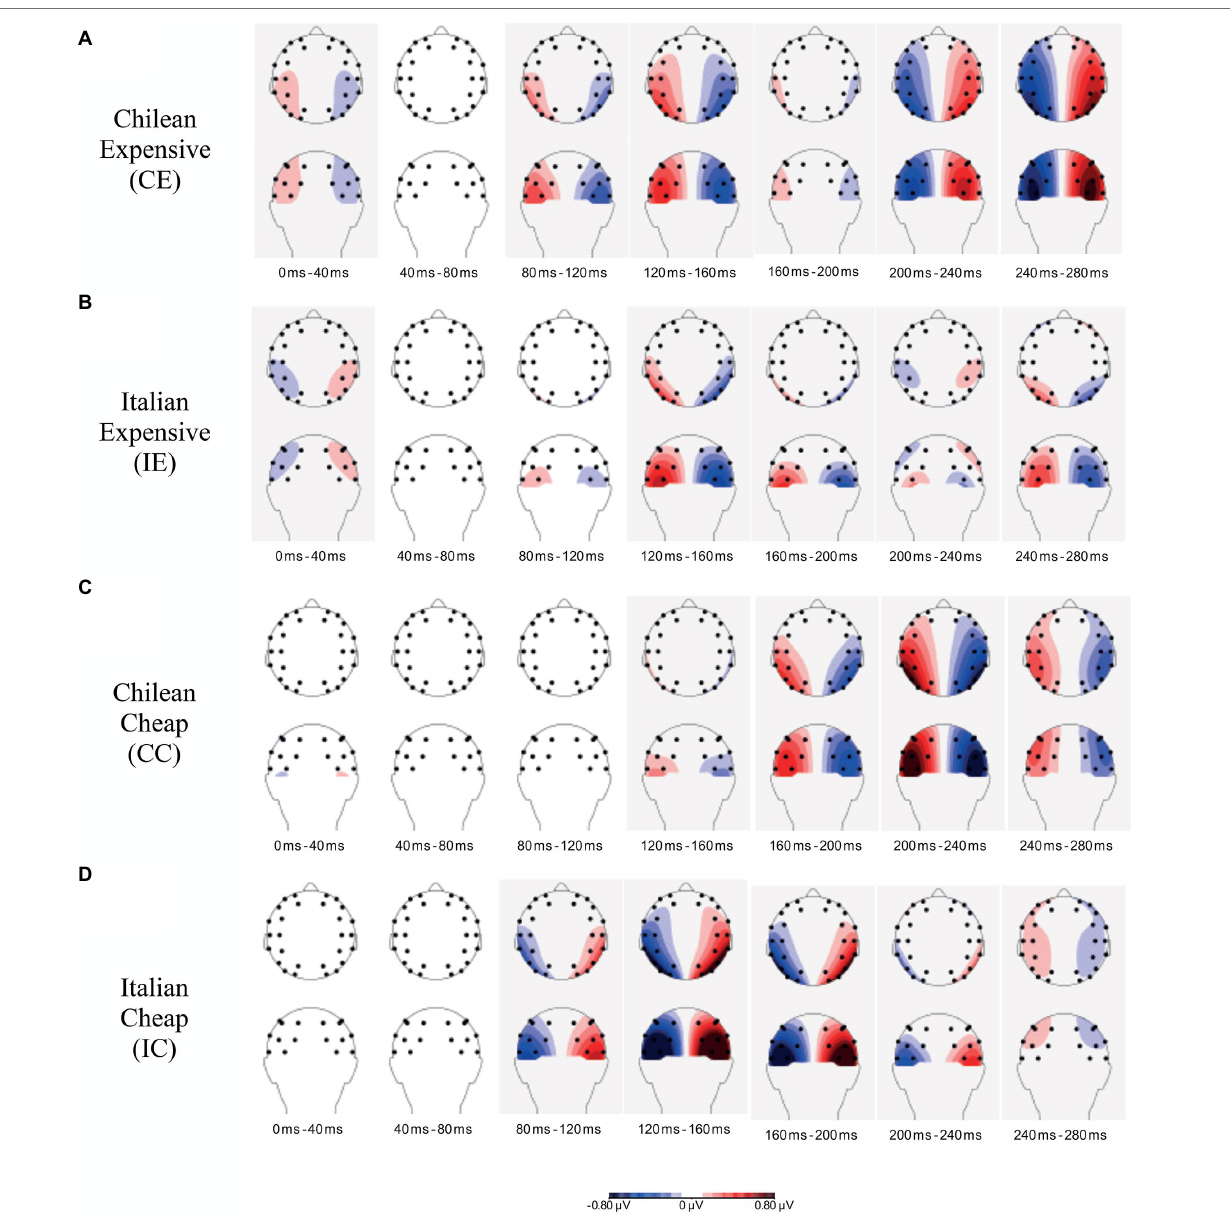
FIGURE 4 | Topographical maps determined for 40-ms time windows (from 0 until 280 ms) after stimuli presentation for all four wines: Chilean Expensive (A) , Italian Expensive (B) , hilean Cheap (C) and Italian Cheap (D) . Contra-ipsilateral differences relative to the label of interest are projected on the left hemisphere, while ipsi- contralateral differences are projected on the right